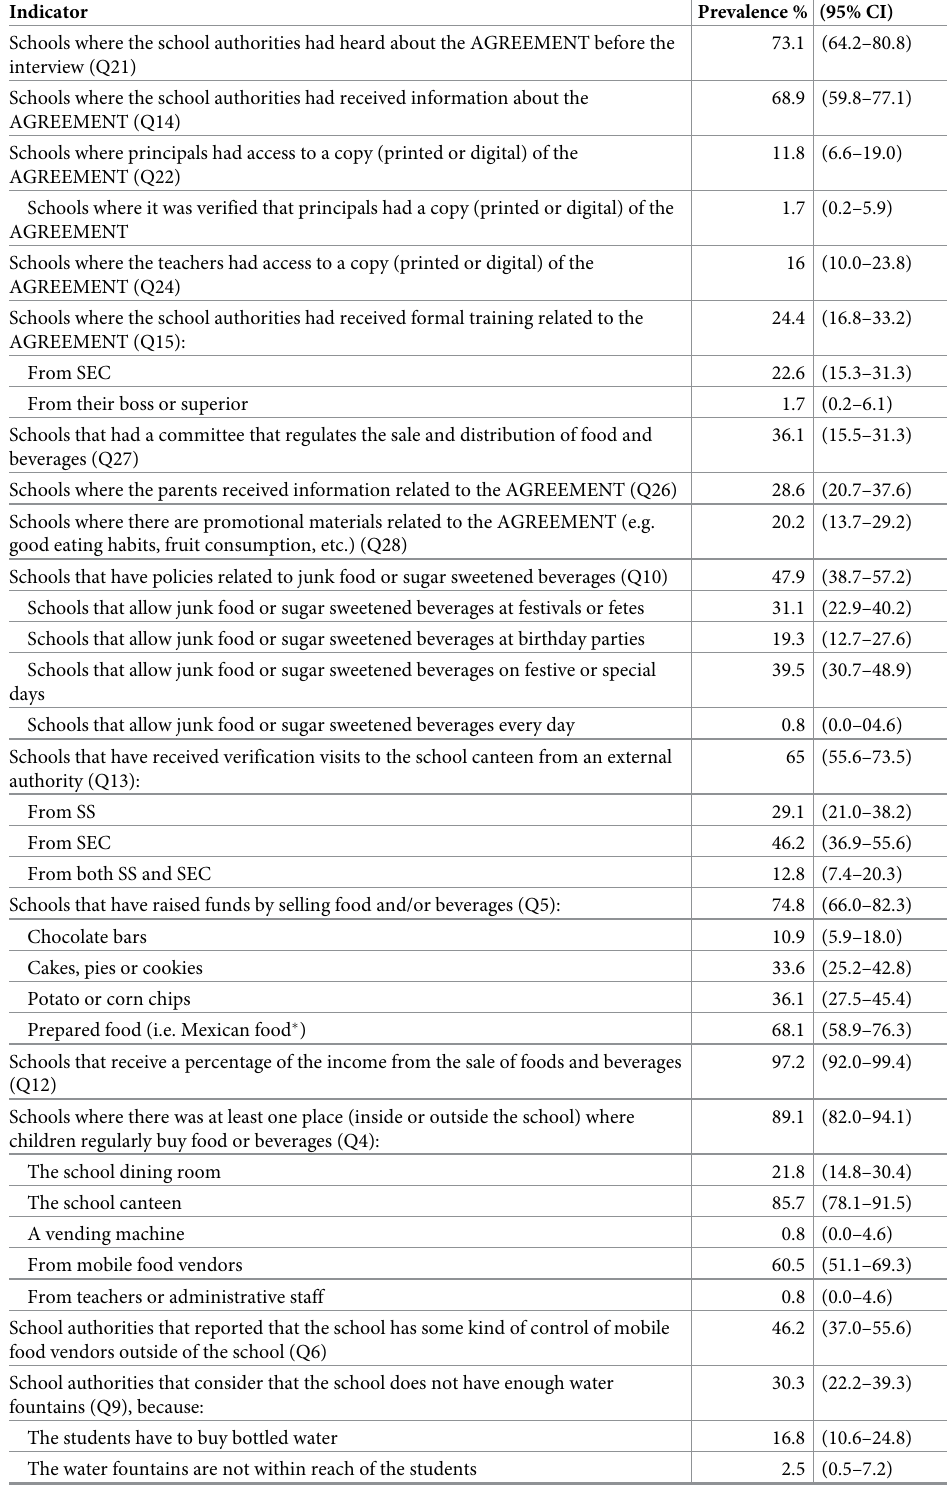
Table 2. Results of the interview with the school authorities (n =